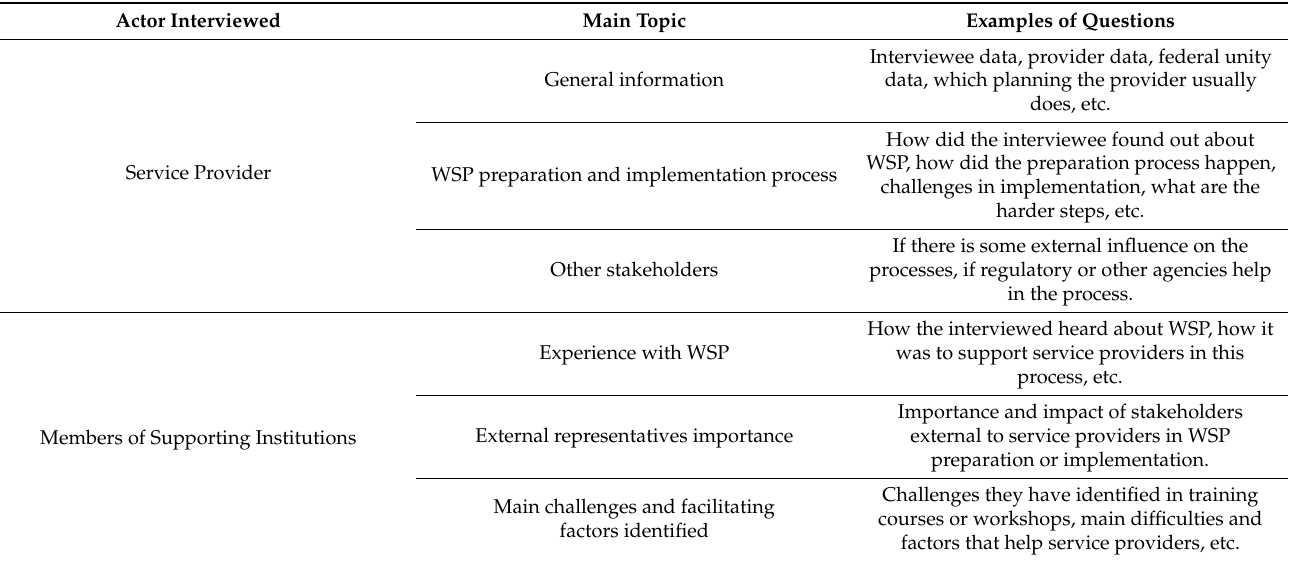
Table 1. Interviewed actors, the main topic addressed, and examples of questions